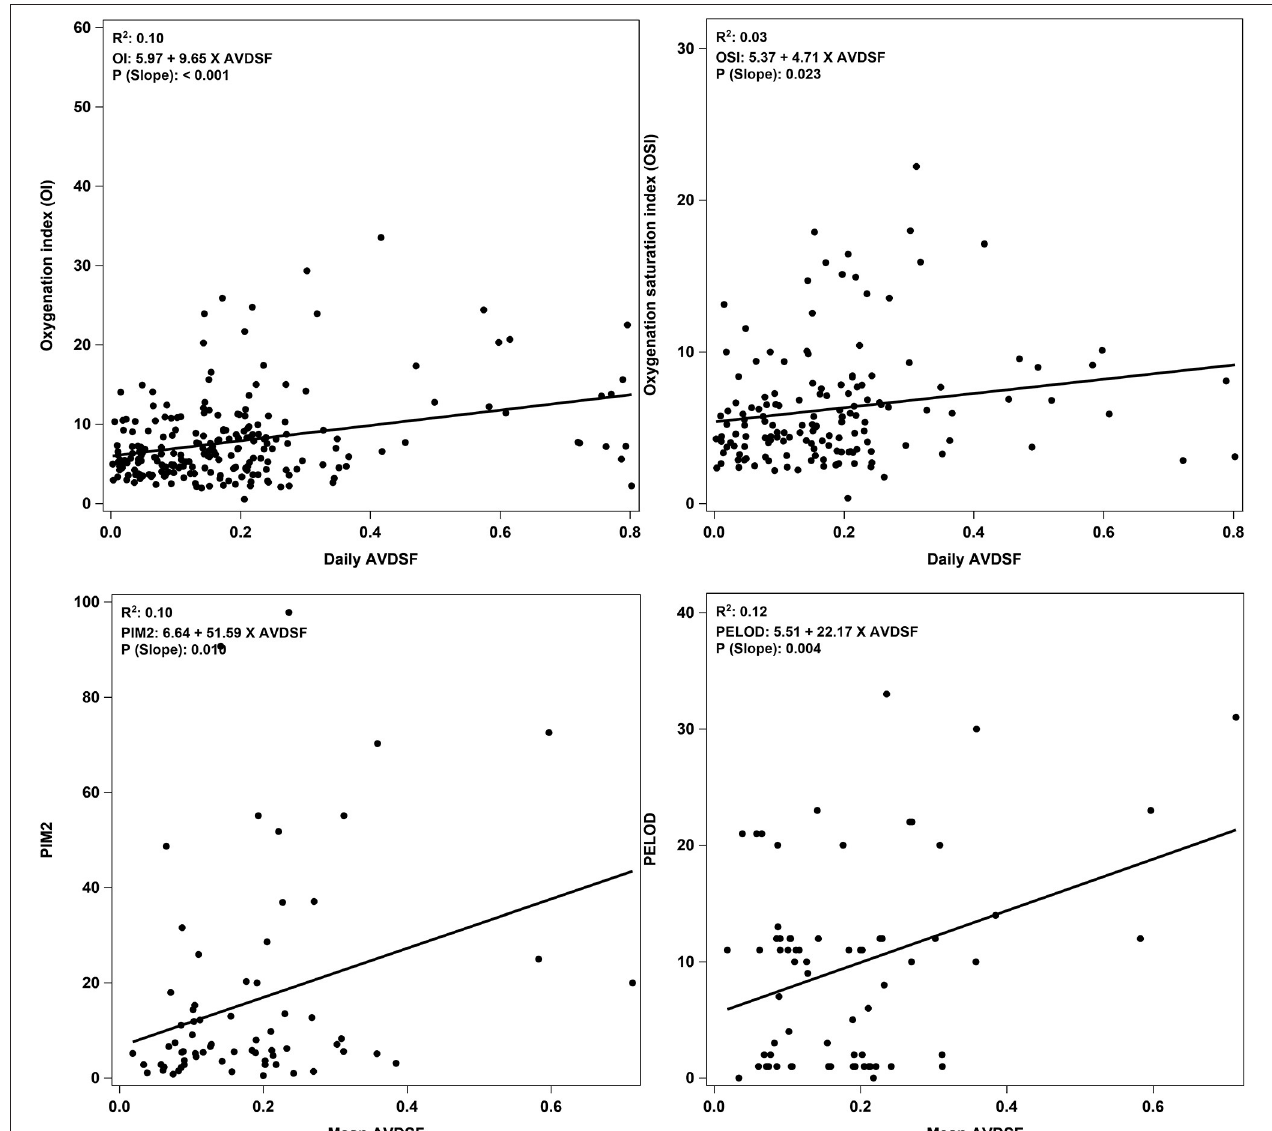
FIGURE 1 | Correlation plots of daily AVDSF with OI and OSI, and mean AVDSF with PIM 2 and PELOD score. Correlation plots for OI and OSI were generated by using daily AVDSF calculations. Correlation plots for PIM2 and PELOD score were generated by using mean AVDSF of 7 days. AVDSF, Alveolar dead space fraction; OI, Oxygenation index; OSI, Oxygen saturation index; PIM 2, Pediatric Index of Mortality 2; PELOD, Pediatric Logistic Organ